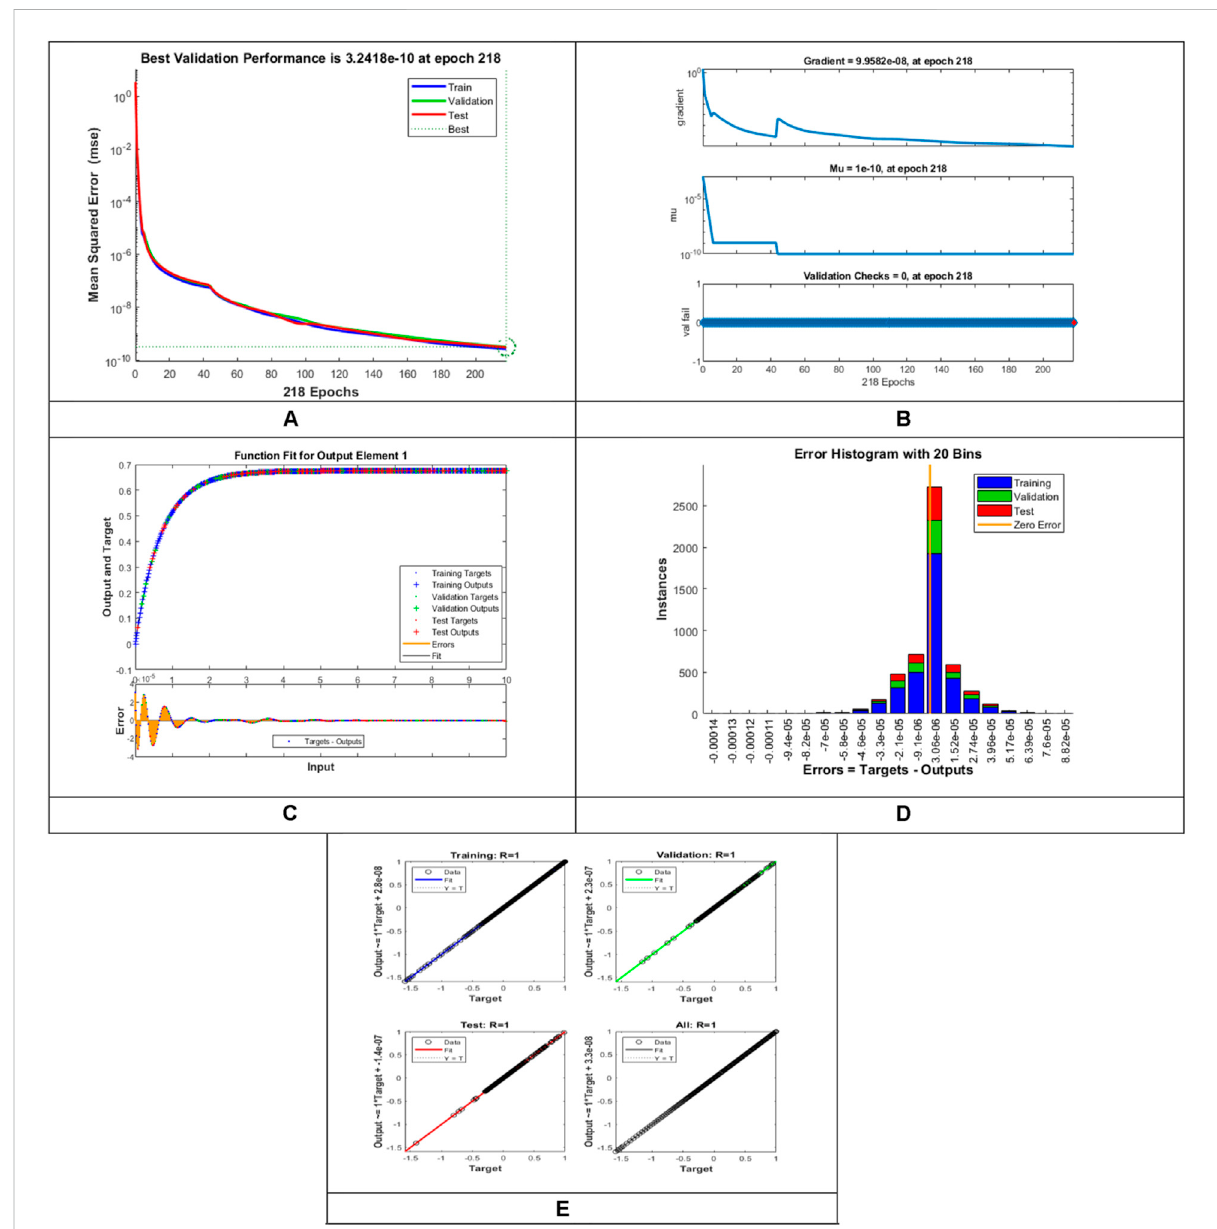
FIGURE 12 Pictorial illustration for the LMLA-BPNN base on variants of Le vs ϕ ( η ) for MHD-WNF-HGA. (A) M-S-E demonstration, (B) transition state analysis, (C) curve fi tting, (D) error histogram, (E) and regression